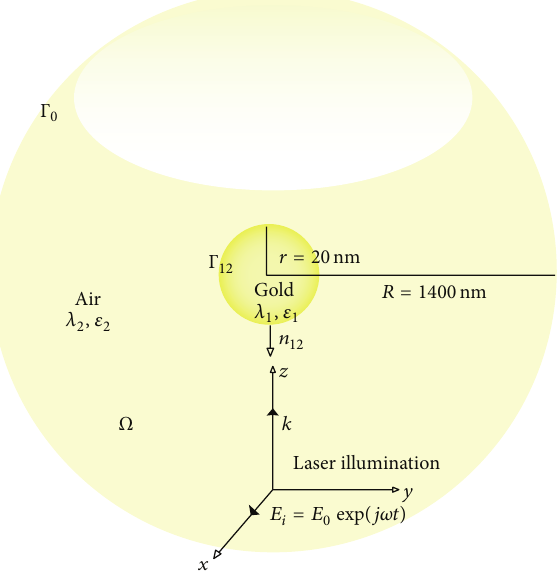
Figure 1: Metallic nanosphere immersed in air and illuminated by a monochromatic linearly polarized plane